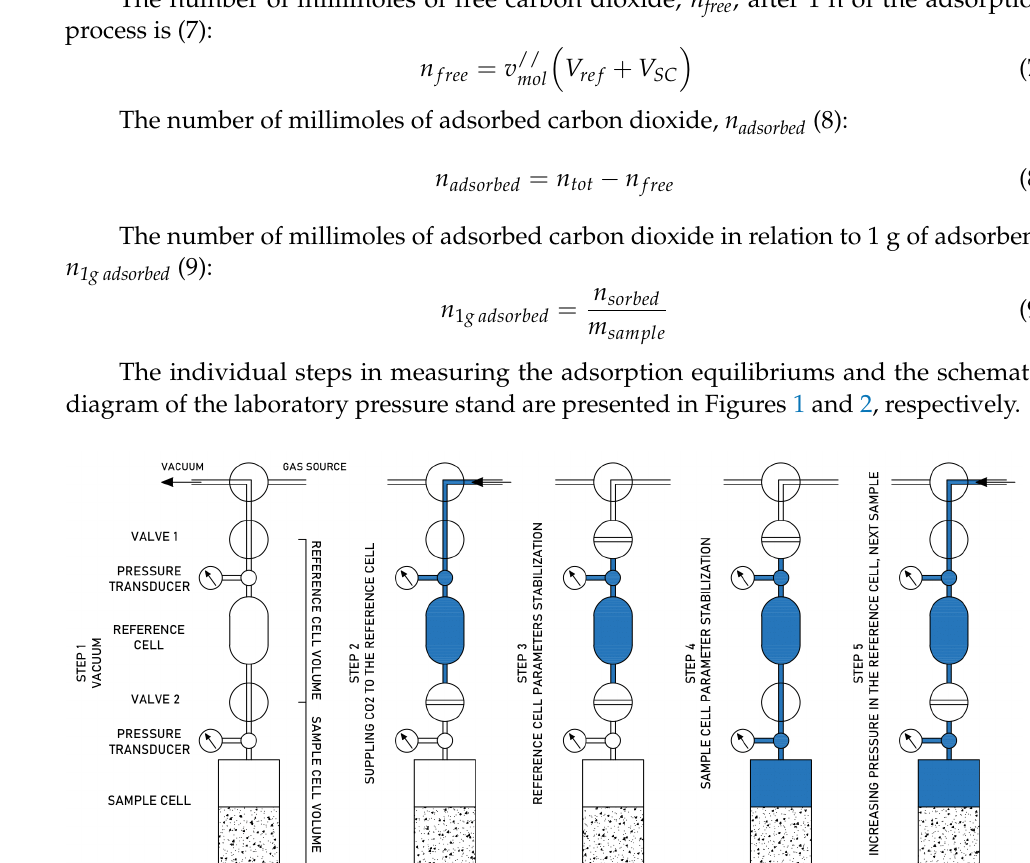
Figure 1. The individual steps in measuring the adsorption equilibriums of porous materials through the use of a laboratory pressure stand.